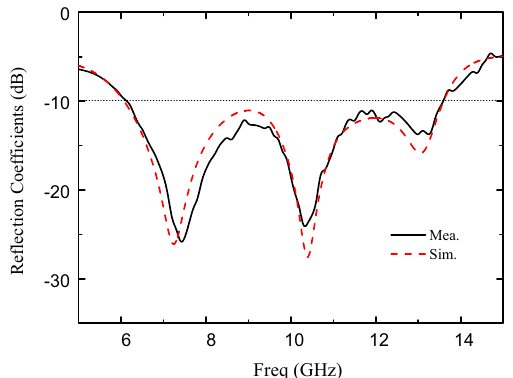
Fig. 10 Measurement curves of the reflection coefficient of the proposed UWB circularly polarized antenna. The simulation results are also included for the comparison